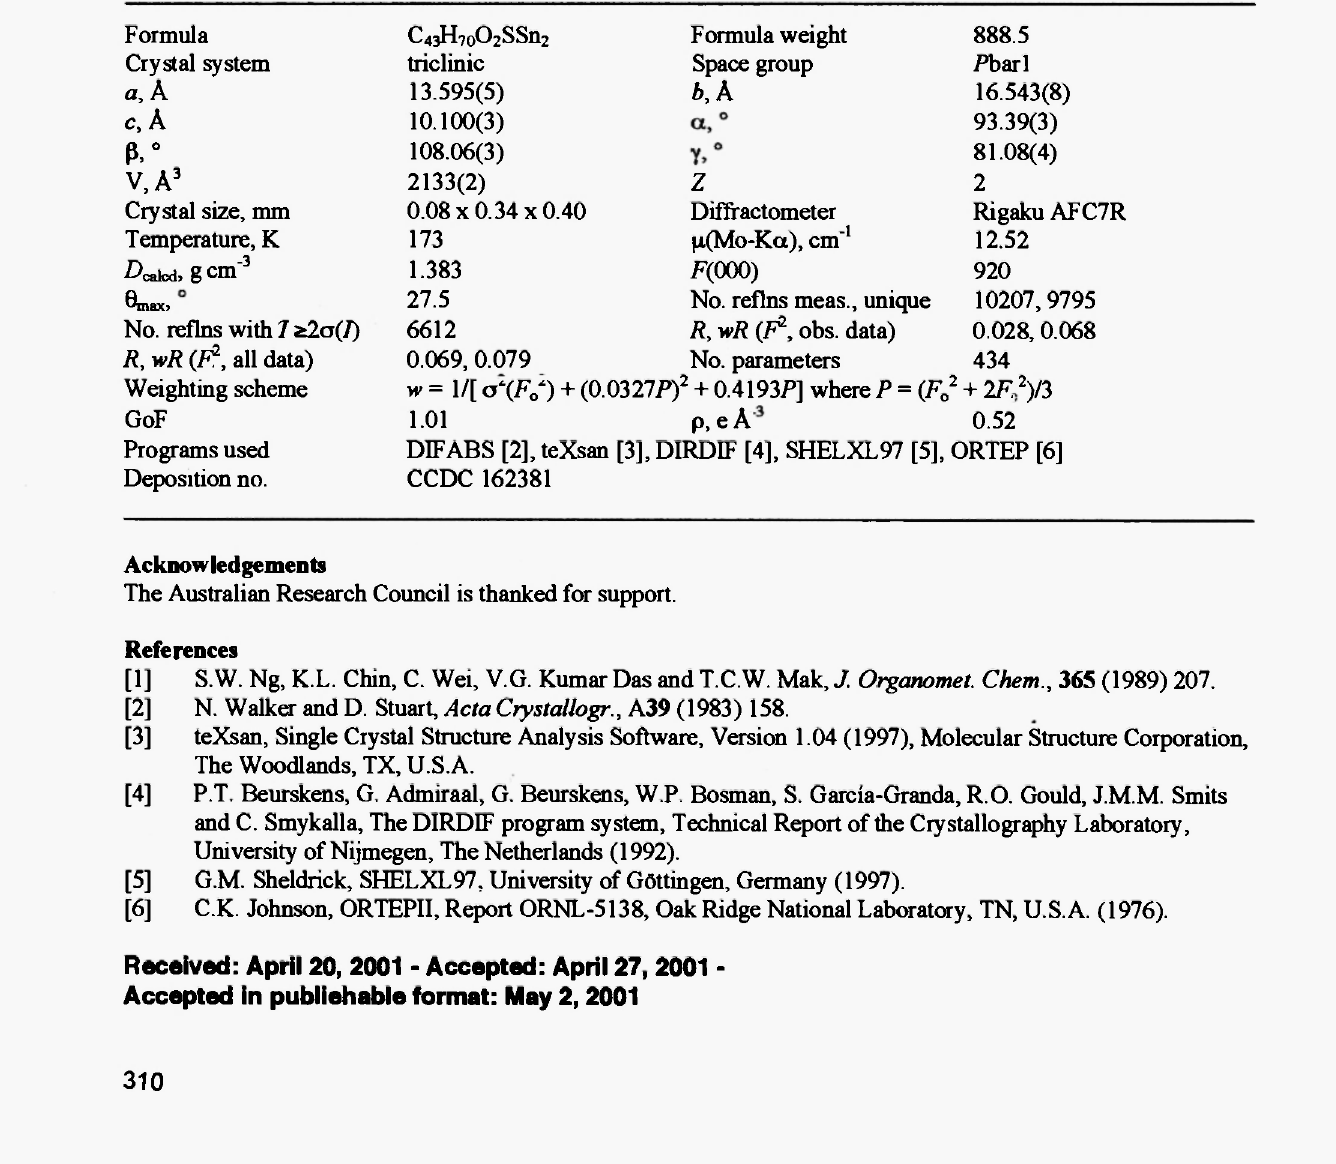
Table 1. Crystallographic data for